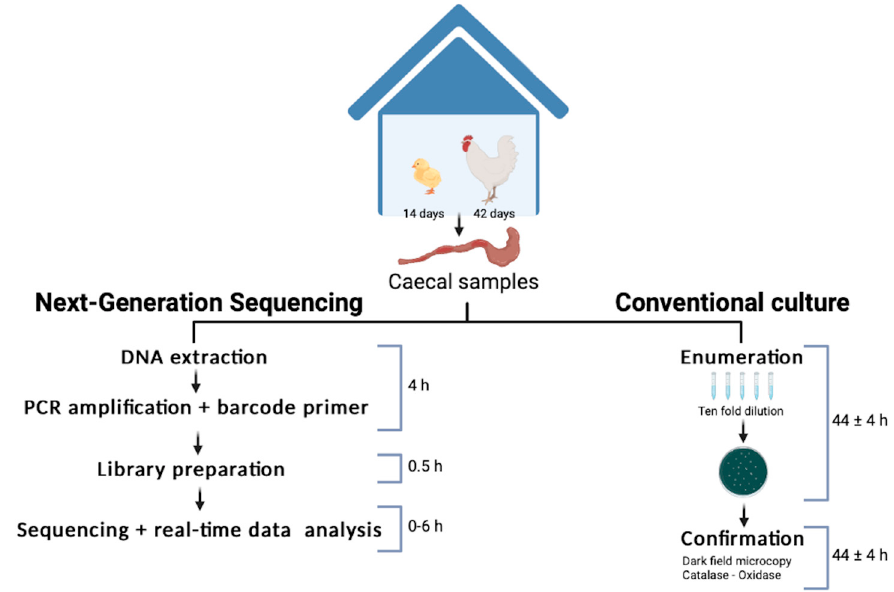
Figure 1. Timeline for the rapid method developed at farm level compared with the current culture detection method. The timeline is based on the work of one laboratory technician.